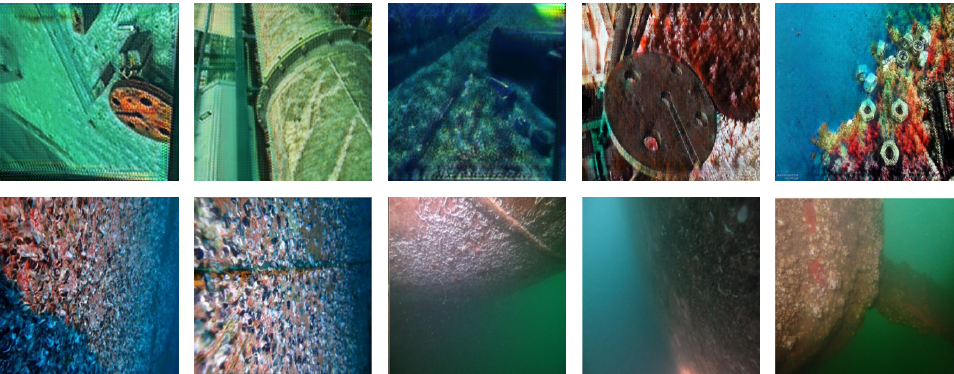
Figure 7. Real and artificial underwater